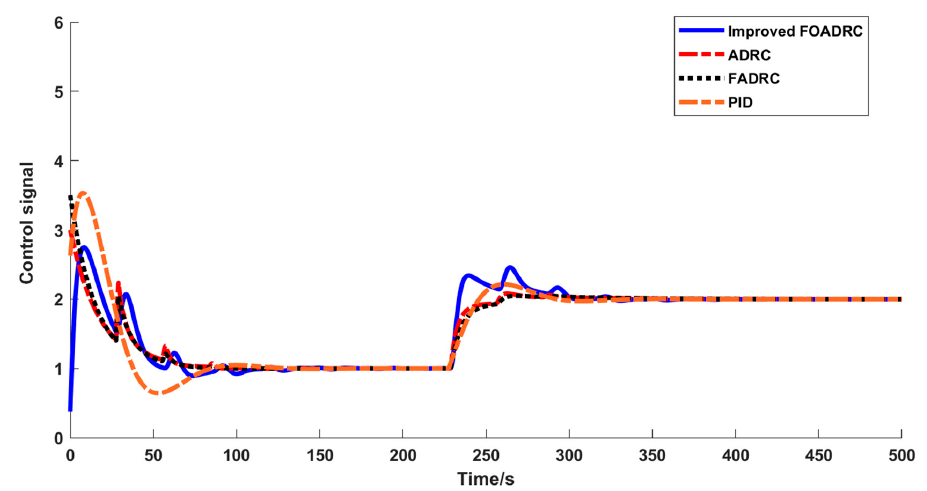
Figure 12. Model modification +10% control signals. Table 4. Parameter Optimization for Di ff erent Algorithms.